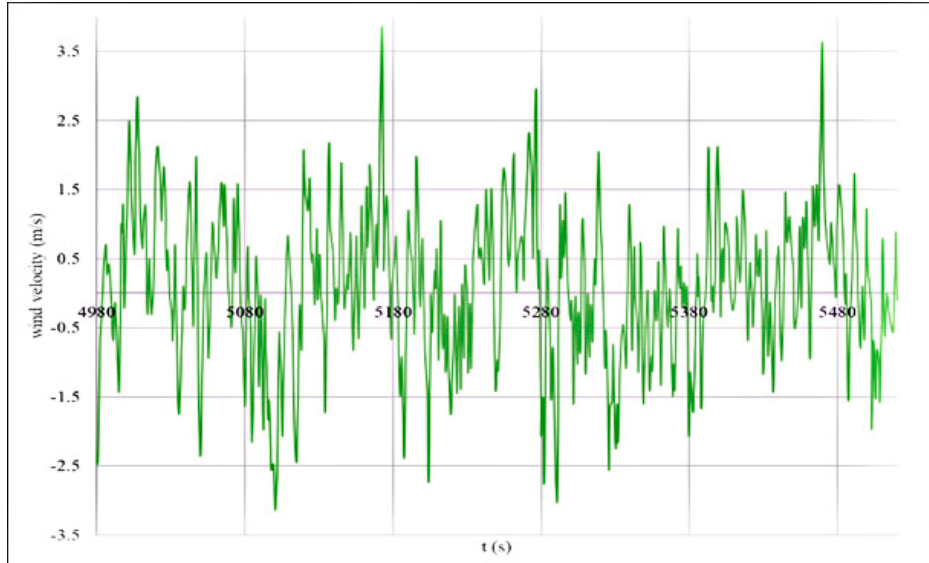
Figure 5. The wind velocity during the period of the experimental test.